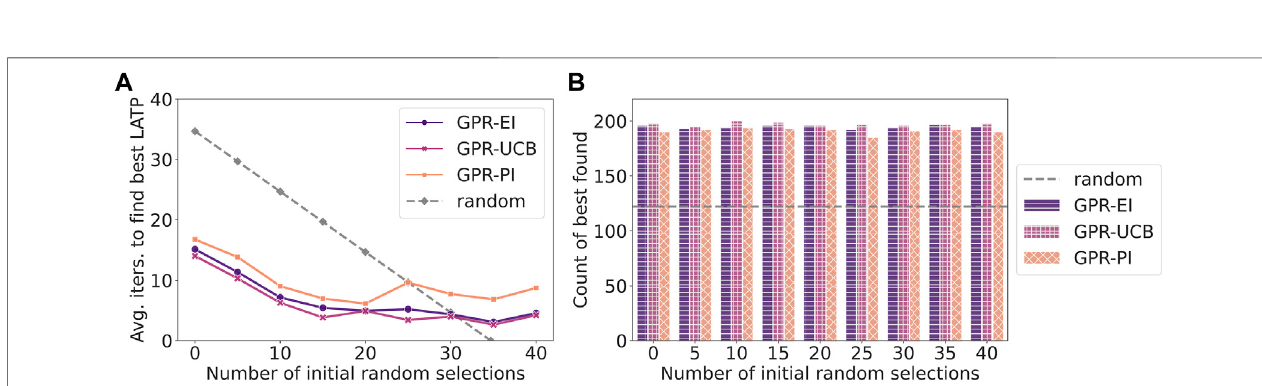
FIGURE 2 | Illustration of the prediction (A) based on known data points (white points) and prediction with uncertainty (B) from the Gaussian process regression with UCB model in the search space. It shows the ionic conductivity (S cm − 1 ) of LATP with stoichiometric H 3 PO 4 (0.0 wt%), where higher values are indicated with brighter color. The x-axis represents the holding time, while the y-axis represents the sintering temperature. It can be seen that the position of the possible optimum (the lightest area) has shifted when considering the uncertainty.